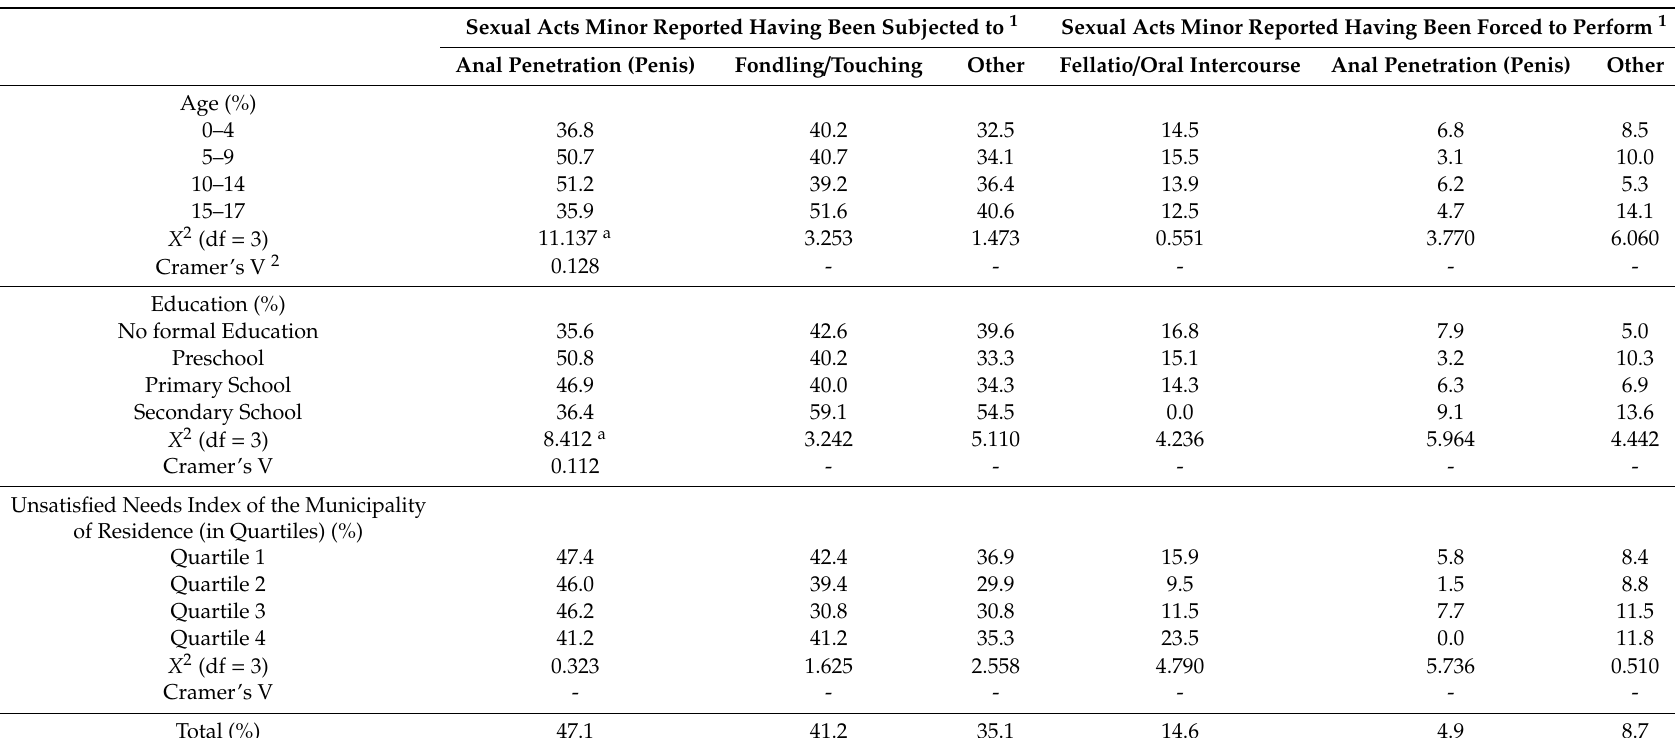
Table 3. Sexual acts the minor reported having been subjected to or forced to perform, by the characteristics of the alleged victims ( N =